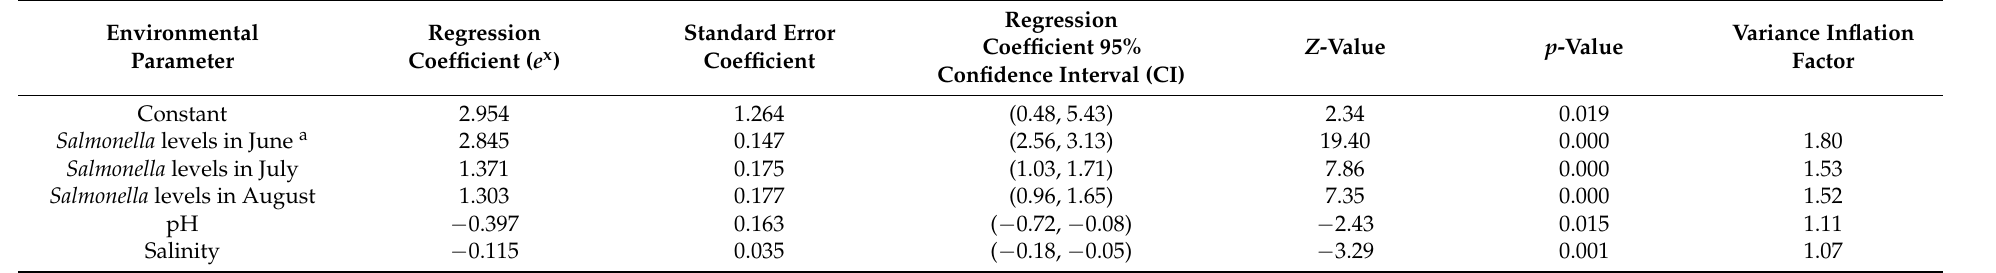
Table 3. Parameters examined with Poisson regression analysis for Salmonella detection levels recovered from river water in northwestern